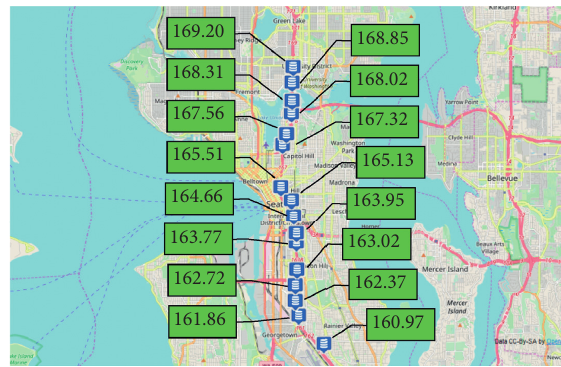
Figure 3: The locations of the 16 detectors used in the case